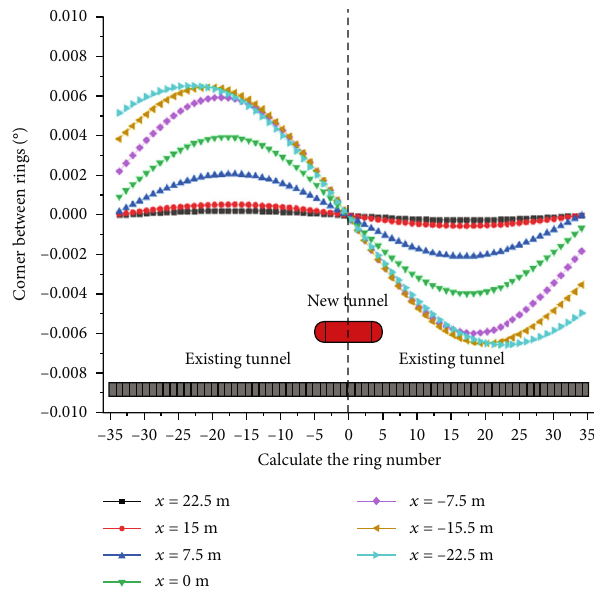
Figure 18: Rotation angle between shield tunnel